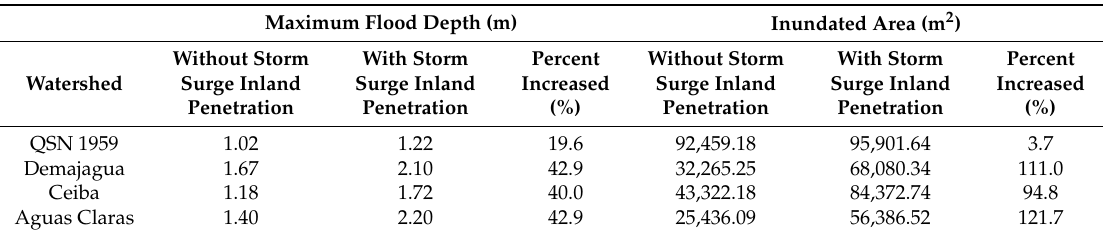
Table 5. Maximum flood depth and inundated area for the two different flooding scenarios at the coastal zone of the